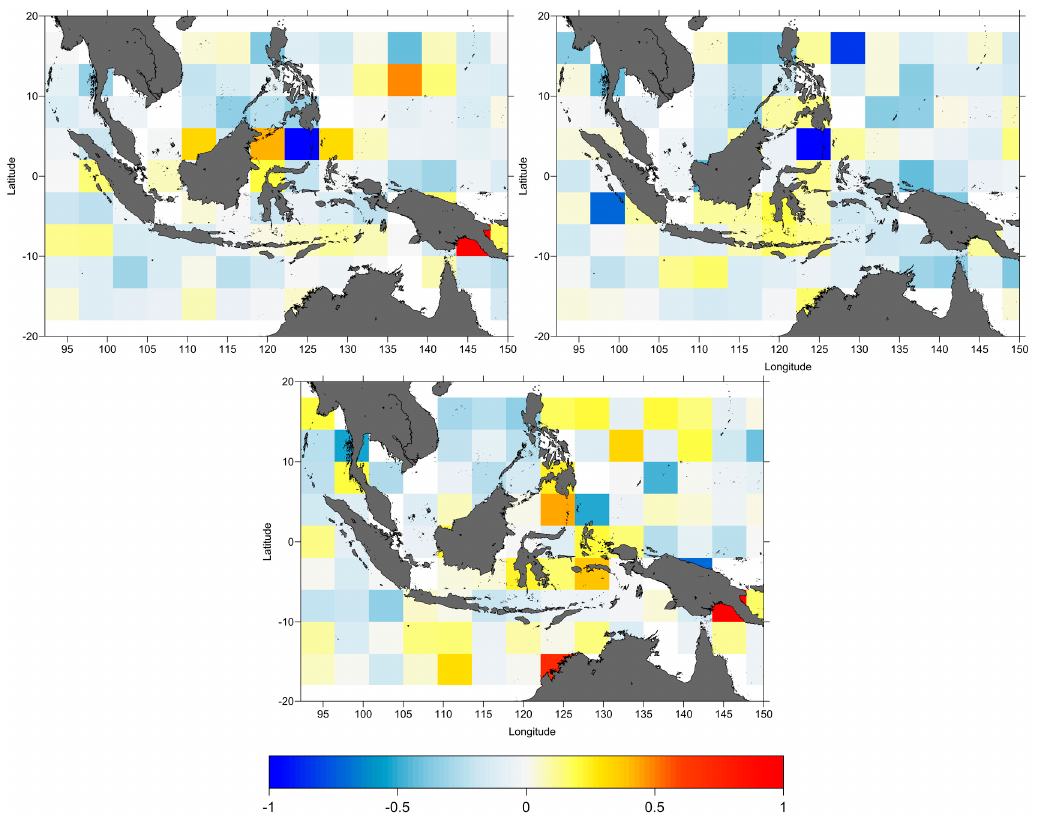
Figure 4. SLA variance differences at crossovers (cm 2 ), ERA − NCEP, for TOPEX/Poseidon cycles 1 to 364 ( top-left ); Jason-1 cycles 1 to 259 ( top-right ) and Jason-2 cycles 1 to 280 ( bottom-middle ).